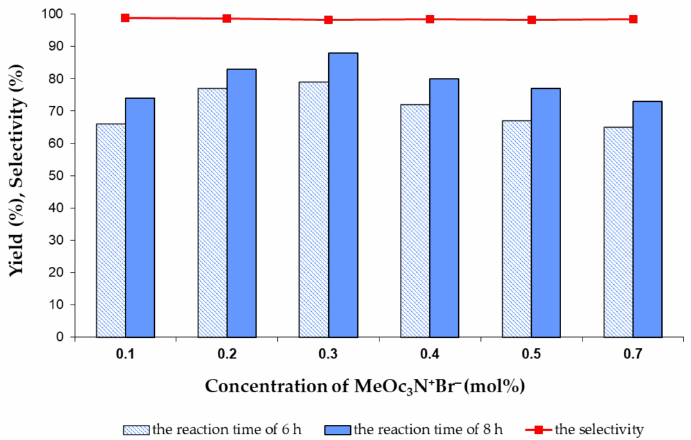
Figure 3. The effect of the MeOc 3 N + Br − concentration on the mono- O -allylation of butane-1,4-diol by allyl chloride toward 4-allyloxybutan-1-ol in the presence of 50% NaOH(aq) (the reaction conditions: see Table 1, entry